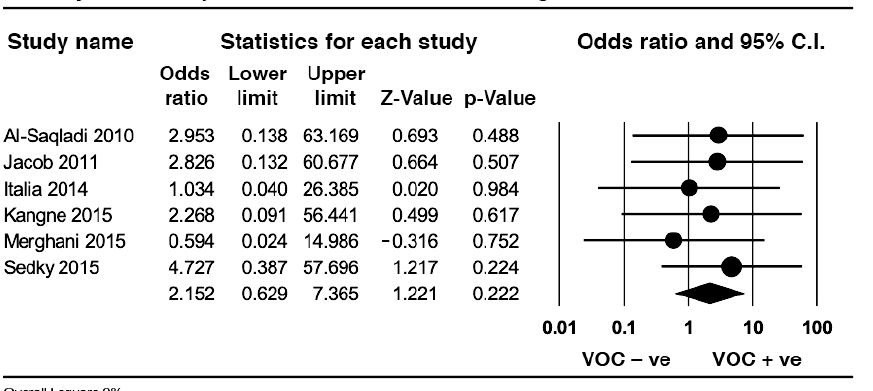
Figure 6. Effect size of the pooled prevalence of the methylenetetrahydrofolate reductase TT in sickle cell disease without and with ischemic stroke.